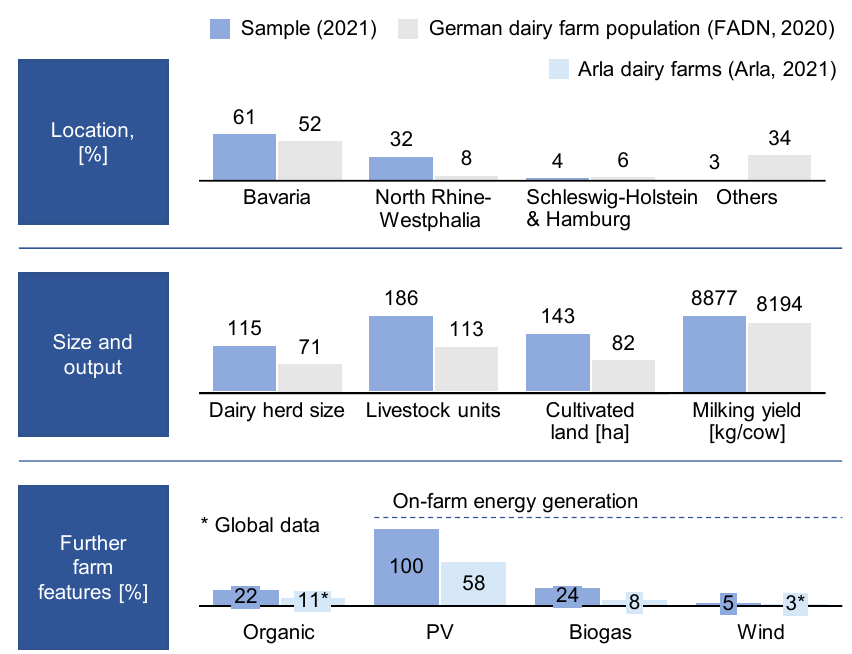
Figure 1. Farm characteristics of the survey sample compared to data from [23,24].